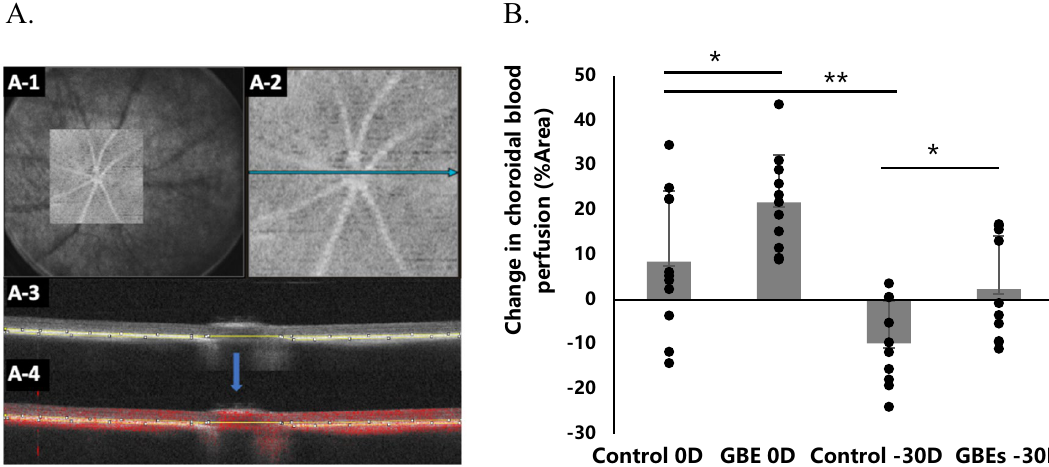
Figure 3. GBEs increased choroidal blood perfusion in a murine model. ( A ). Choroidal blood perfusion was measured by OCTA, which allows for a choroid enface angiogram and corresponding B-scan. ( A -1). En-face angiography image. ( A -2). Angiography of 9 mm in length and width centered on the optic nerve. ( A -3). The En face angiogram corresponds to the B-scan image. The choroid region is circled in yellow on the B-scan image. ( A -4). OCTA generated a B-scan angiogram of the choroid layer. The proportion of the red dots in the choroid region was calculated using the area measuring tool in ImageJ, the area beyond the red dot (100-%Area) is the choroidal blood perfusion area. ( B ). The changes in choroidal blood perfusion after 3 weeks of GBEs feeding were significantly higher than those in the normal feeding group, regardless of whether myopia induction was performed ( p < 0.05) (n = 10). * p < 0.05, ** p < 0.01, bars represent mean + / − standard deviations. The one-way ANOVA was used to determine significant